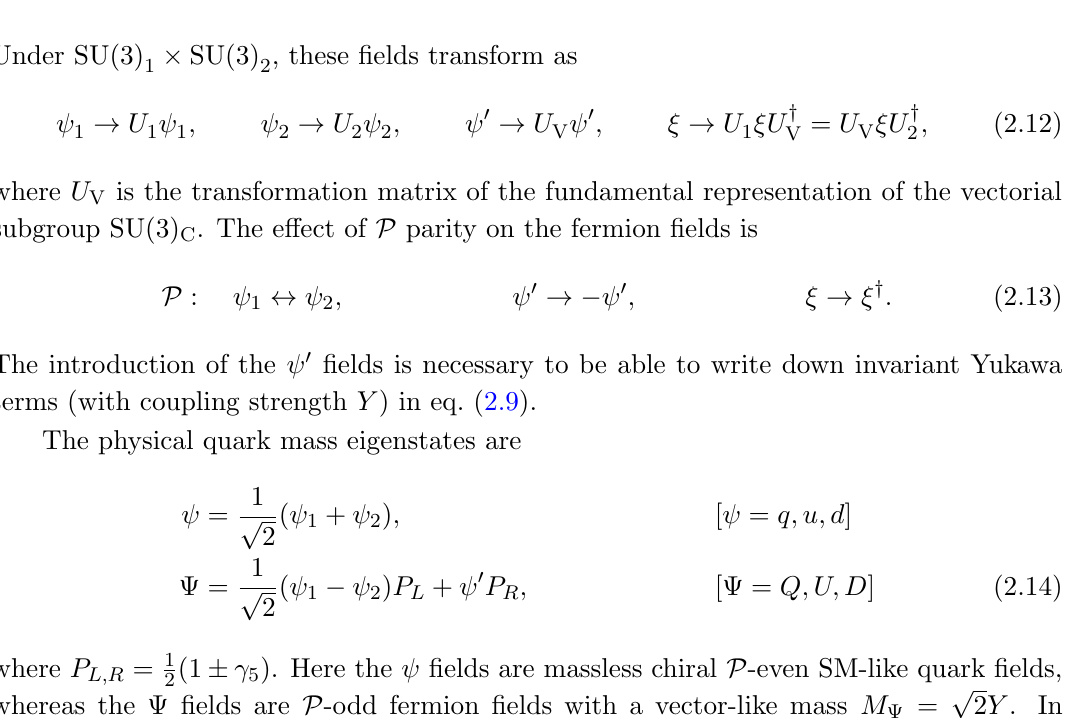
Table 1 . Quantum numbers and chirality of the quark (cid:12)elds in the two-site symmetric coloron